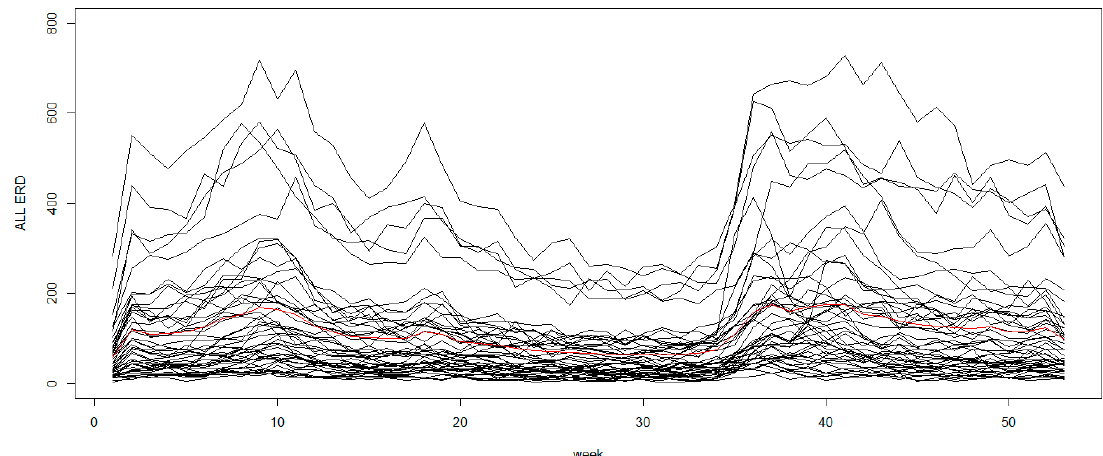
Figure 5. Weekly emergency room discharges of respiratory diseases in South Carolina 2009. The red line represents the mean number of cases averaged over all counties.